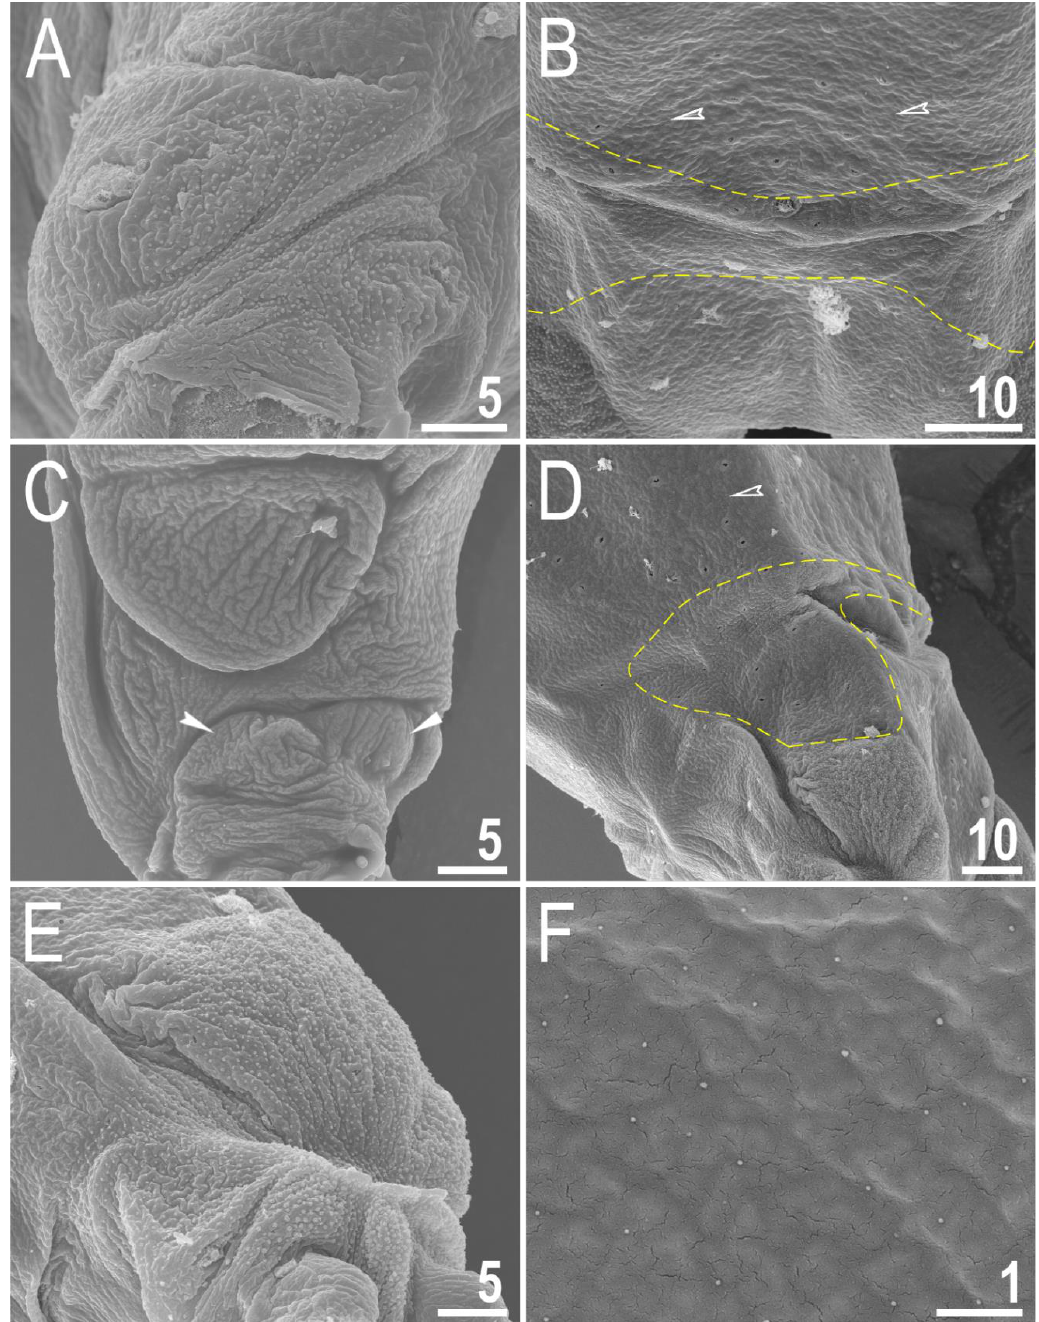
Figure 3. Macrobiotus rebecchii sp. nov. SEM images of leg and body granulation: ( A ) granulation on the external surface of leg III (paratype); ( B ) a band of sparse granulation seen in the caudal region of the last body segment (paratype); ( C ) a pulvinus-shaped cuticular bulge on the internal surface of leg I and an additional cuticular fold positioned distally (paratype); ( D ) granulation on hind leg and a band of sparse granulation seen in the caudal region of the last body segment (paratype); ( E ) granulation on hind leg (paratype); ( F ) body granulation on the dorsal cuticle that is not visible under PCM. The filled flat arrowhead indicates a single continuous cuticular bar above the claws, the filled indented arrowhead indicates an additional cuticular fold on the internal leg surface, and the empty indented arrowheads indicate body granulation that could potentially be faintly visible in PCM in the proximity of the well-visible caudal band of granulation, which is marked by a yellow dashed line. Scale bars in µ